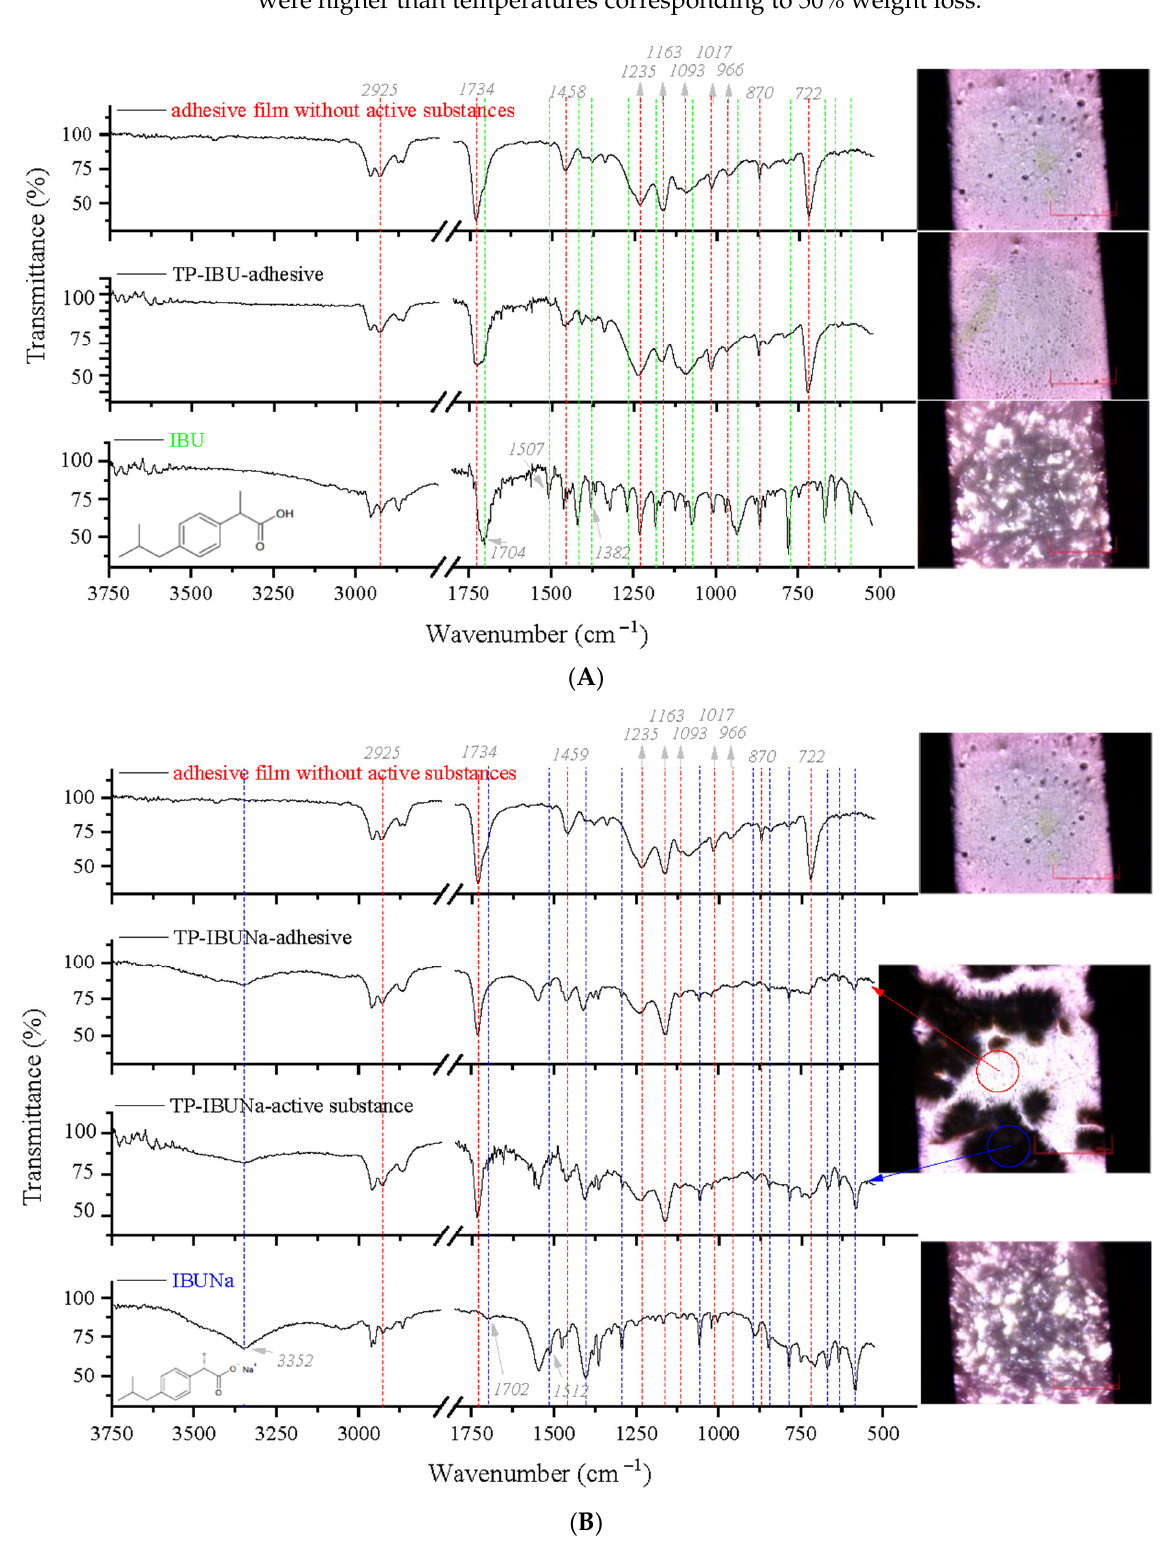
Figure 2. Microspectroscopy analysis of the transdermal patch (TP): ( A ) with the ibuprofen (IBU); ( B ) with IBUNa.